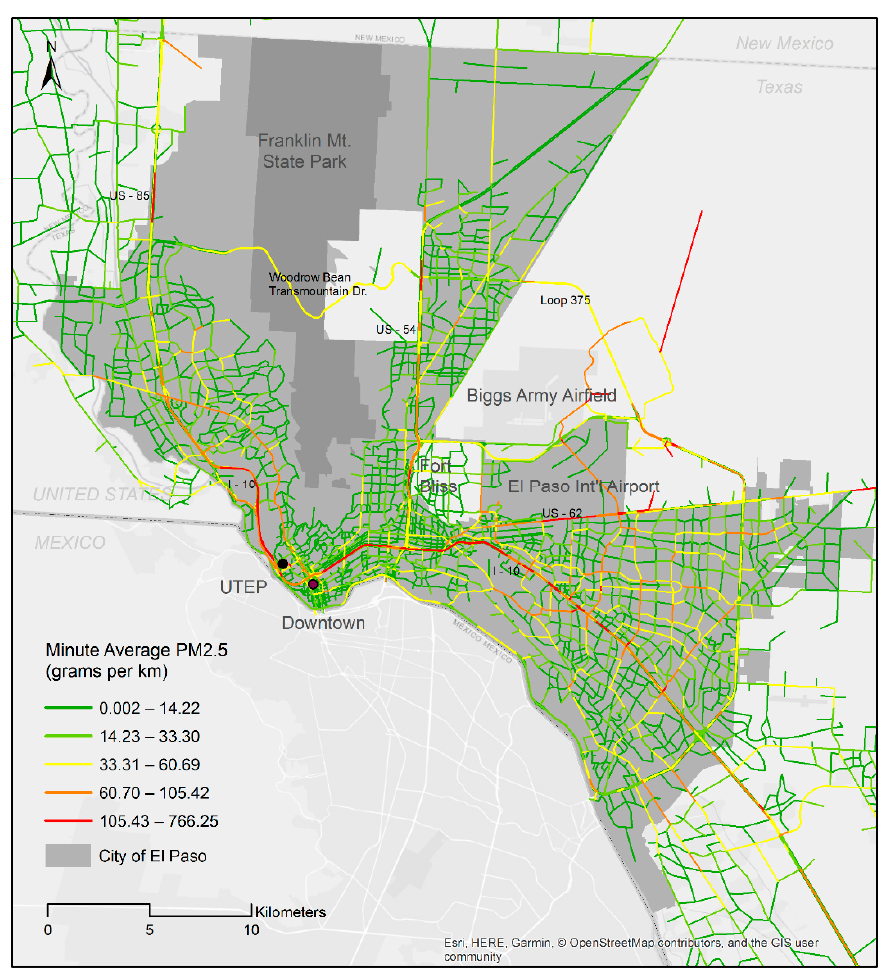
Figure 3. Minute average PM 2.5 emissions.